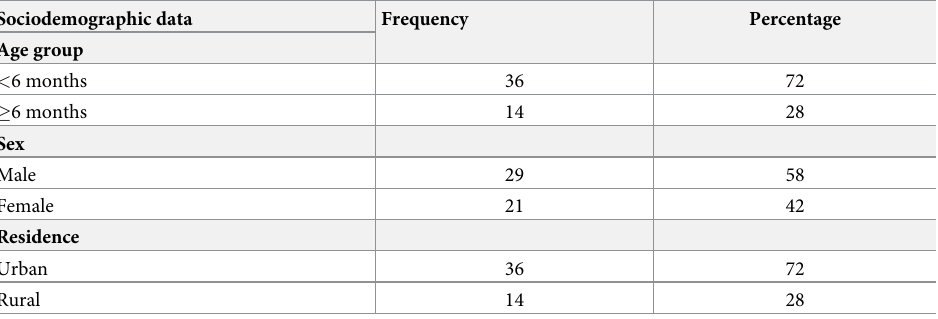
Table 2. Sociodemographic characteristics of the infants suspected for CRS in Amhara Regional State Referral Hospitals, Northwest Ethiopia, December 2015-August 2017.